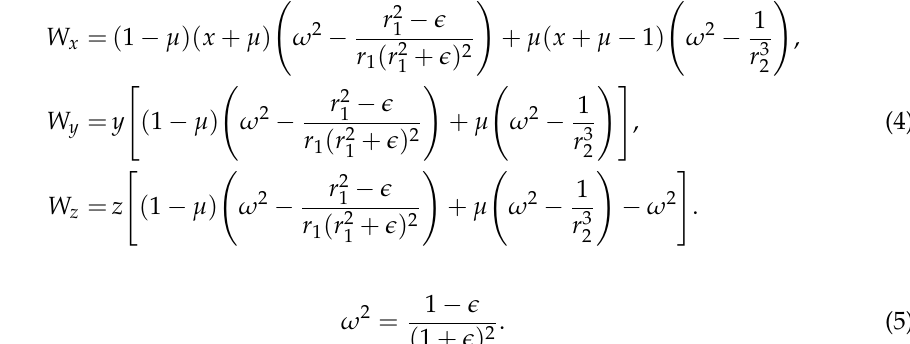
( b ) Zero-velocity curve at (cid:101) = 0.02